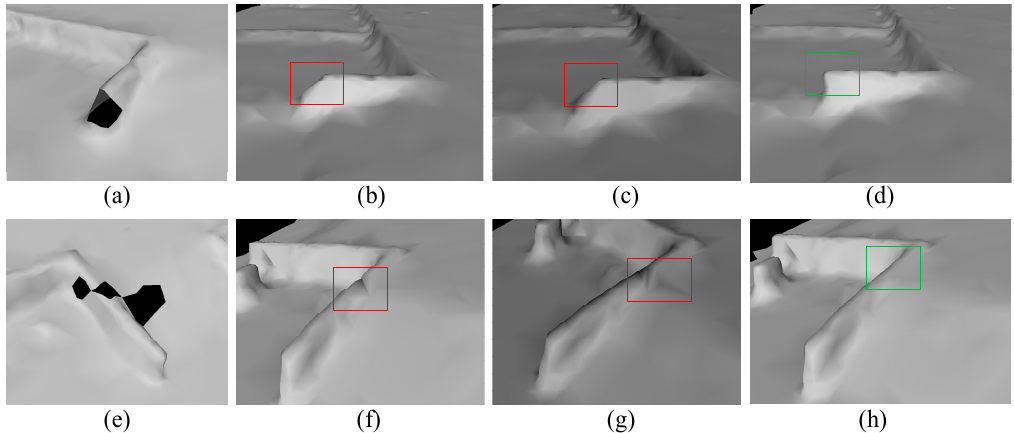
Figure 12. The sharp feature recovery results: (a) and (e) are raw model with holes, the holes are located on the edge and corner of the guardrail, the sharp feature recovery results of VCG as shown by (b) and (f), (c), and (g) indicate the recovery results of MeshFix, and (d) and (h) are the sharp feature recovery results of LIMOFilling.